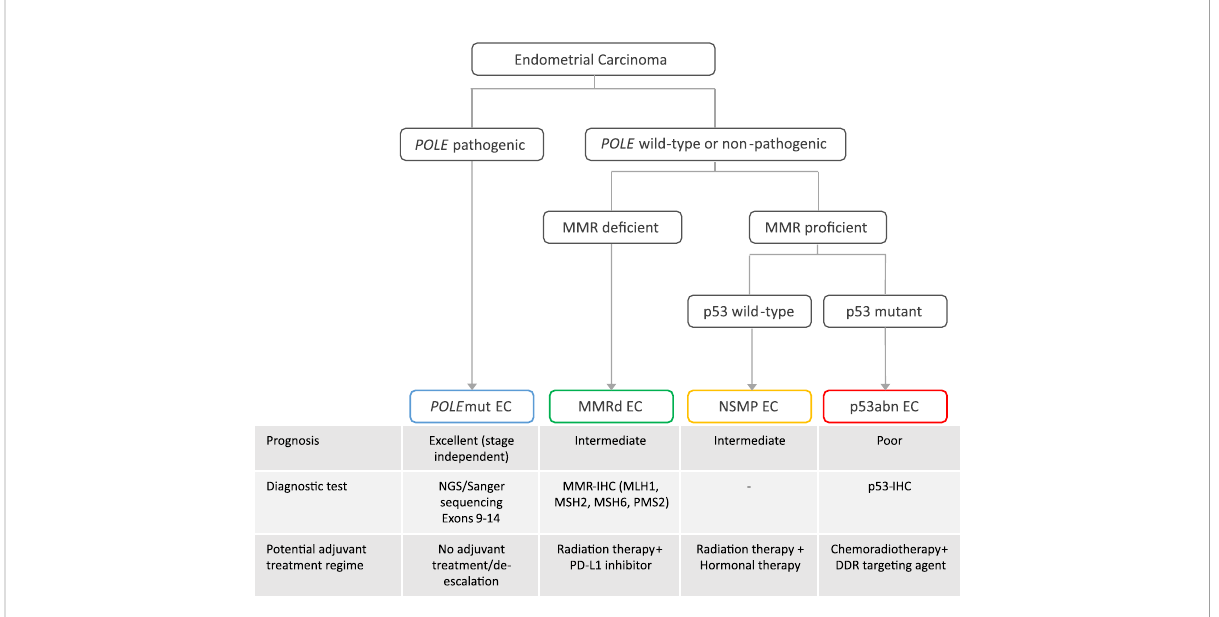
FIGURE 1 The diagnostic algorithm of the molecular classi fi cation of endometrial cancer, associated prognosis, diagnostic test, and potential adjuvant treatment regime. EC, endometrial cancer; NGS, panel next-generation sequencing; POLE mut, polymerase epsilon mutated; MMRd, mismatch repair de fi cient; NSMP, no speci fi c molecular pro fi le; p53abn, p53 abnormal; DDR, DNA damage response; PD-L1, programmed death